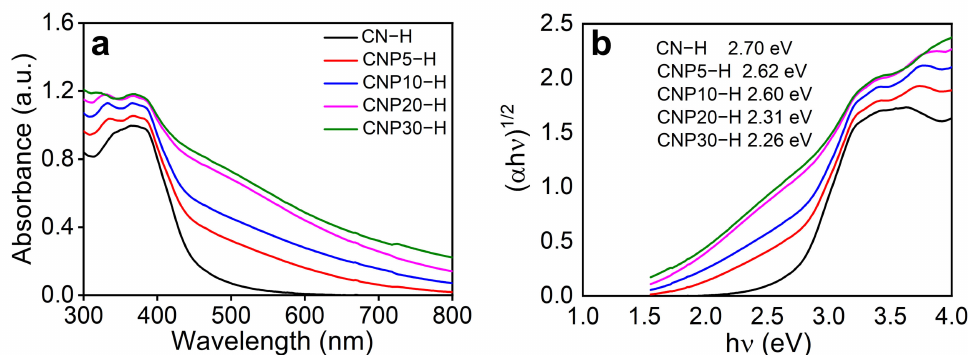
Figure 3. ( a ) UV/Vis absorption spectra and ( b ) band-gap energies of CN-H and